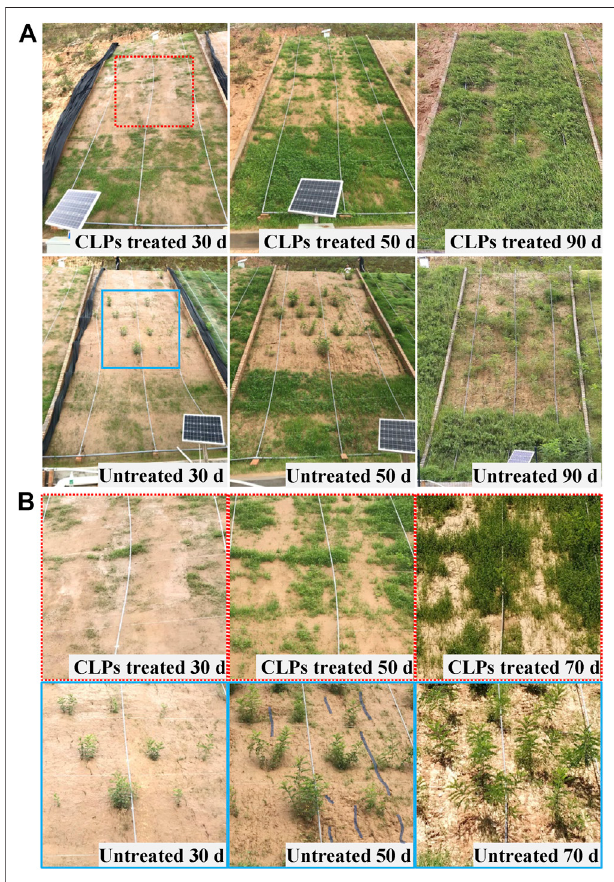
FIGURE 12 | Untreated and cross-linked polymer (CLP)-treated loess hillslopes in the fi eld test over time. (A) Overview and (B) close-up of slopes.